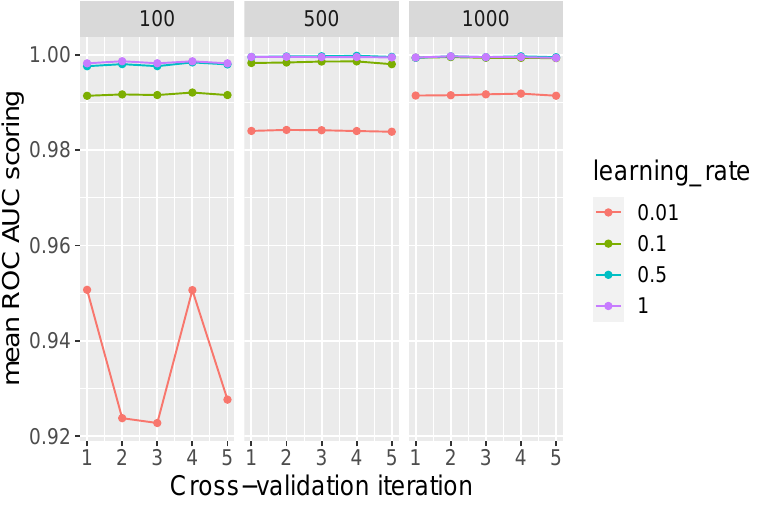
Figure 6. AdaBoost mean score by iteration.